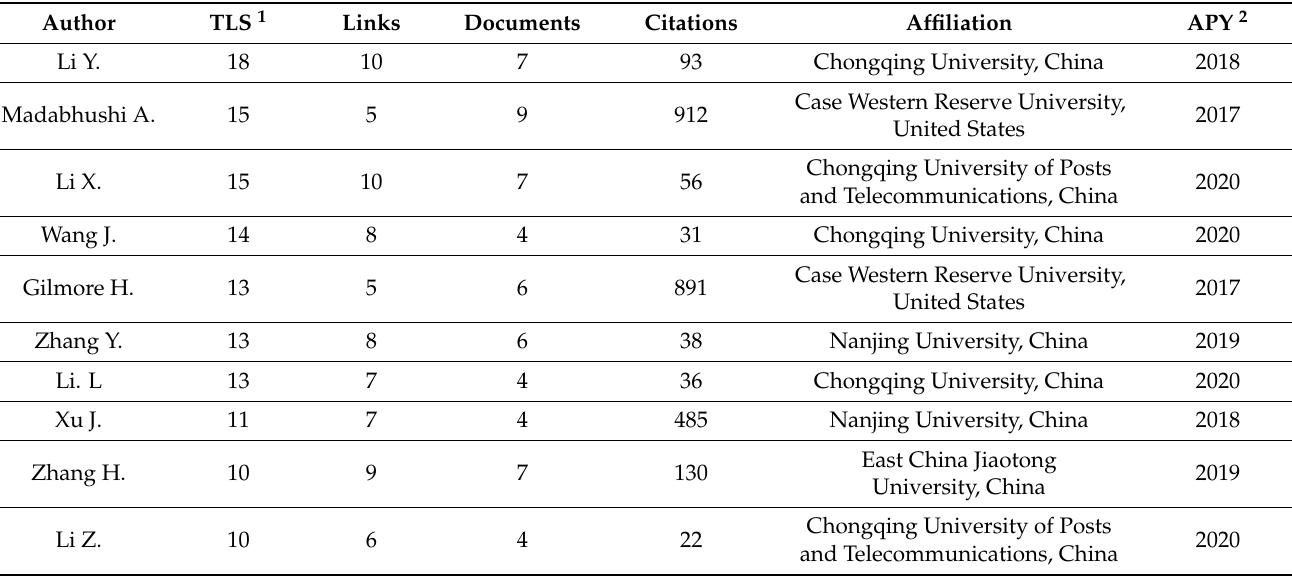
Table 4. Document type from journal.